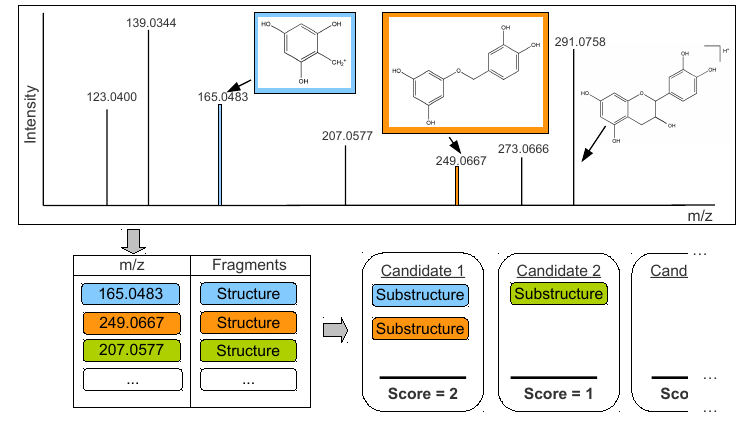
Figure 1: Top: tandem MS spectrum of Epicatechin, with some manually annotated fragment peaks. Below: database table with m/z → fragment association. Candidate compounds are scored, based on the number of substructures they